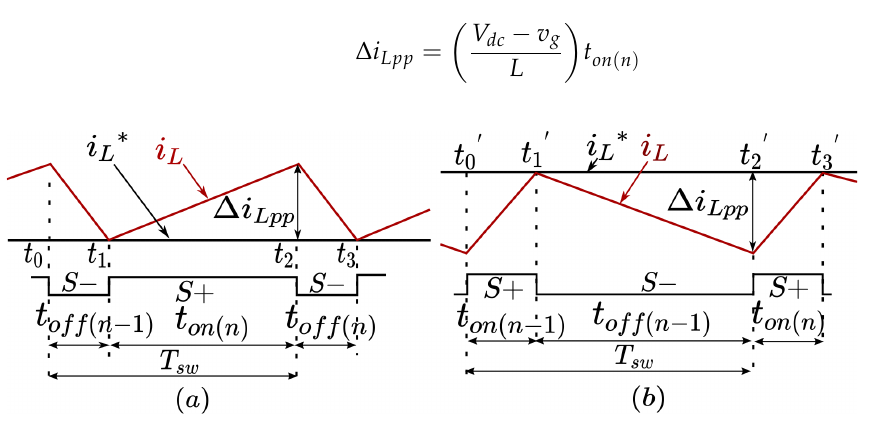
Figure 3. Sketch of inductor current over a switching cycle ( a ) Positive Half Cycle. ( b ) Negative Half